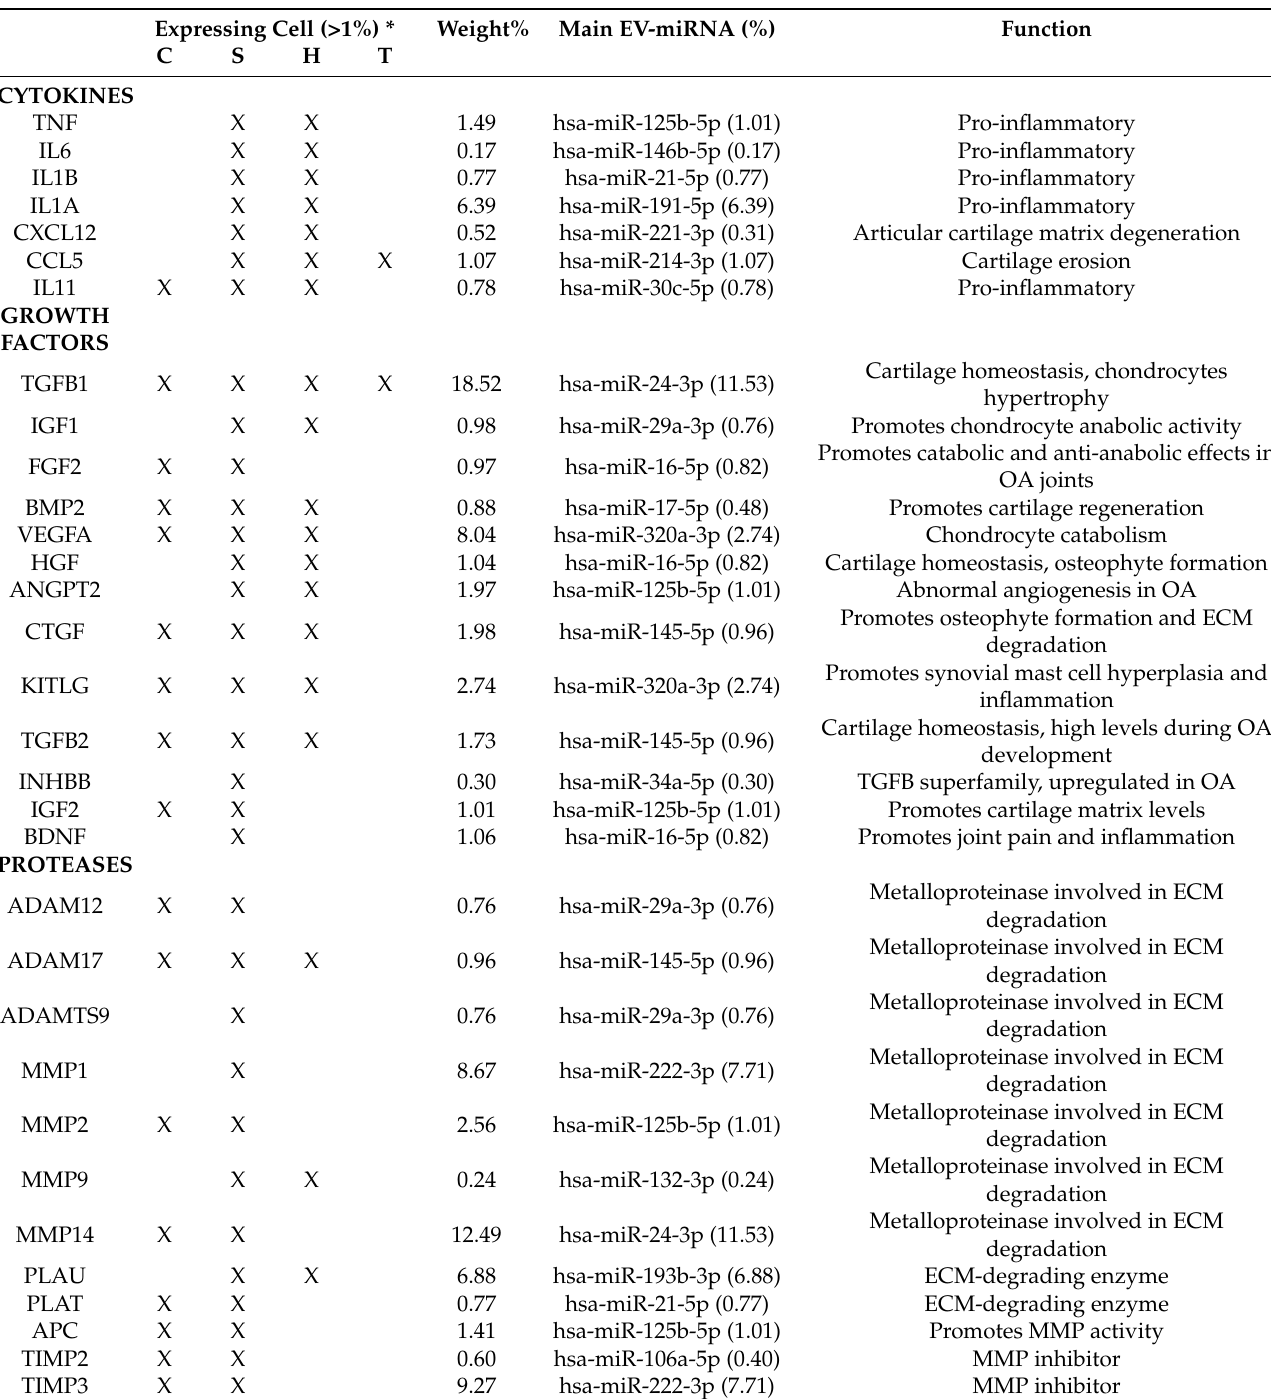
Table 4. OA-related factors targeted by